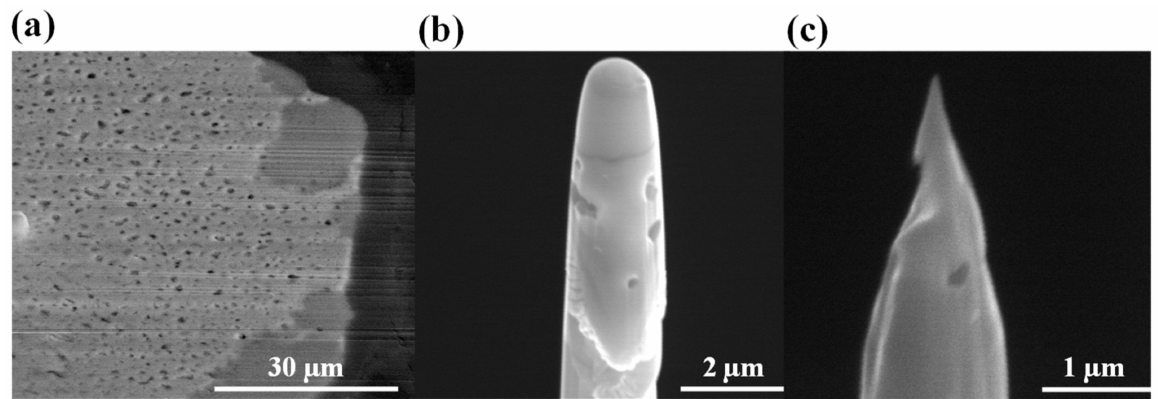
Figure 8. ( a ) SEM images showing porosity in high burnup structure of the M14 sample. ( b , c ) Tip images at different stages of milling for APT